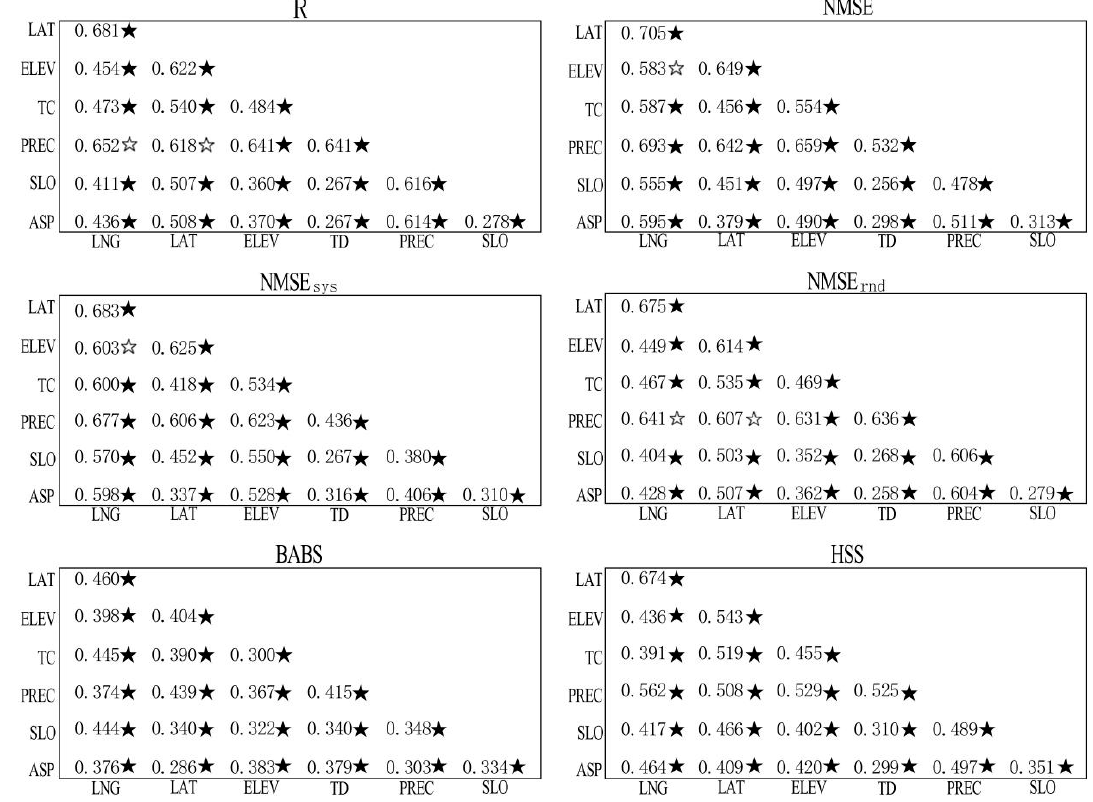
Figure 12. Values of P D,I ( D 1 ∩ D 2 ) of interaction detection for accuracy indicators (“ ☆ ” indicates bivariate enhancement, while “ ★ ” indicates nonlinear enhancement).